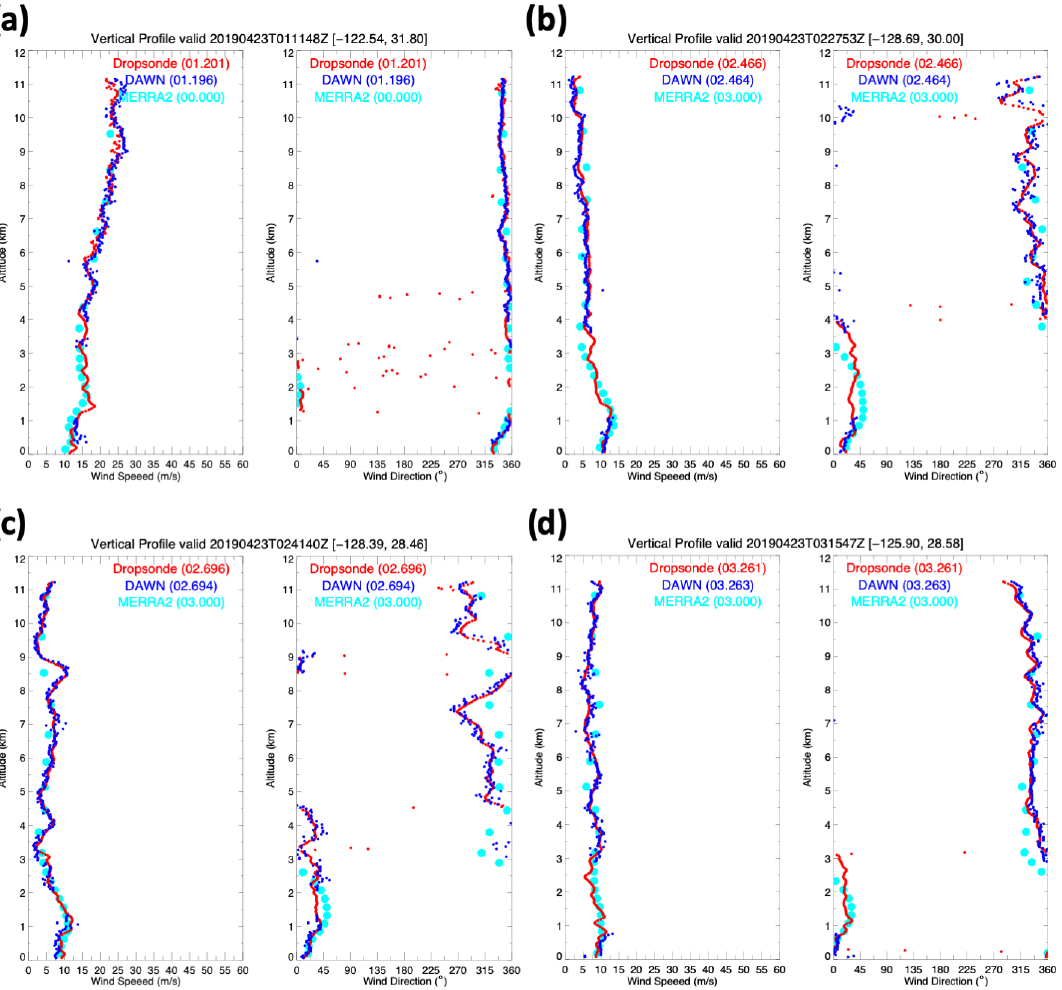
Figure 7. Dropsonde (red), DAWN (blue), and MERRA-2 (cyan) for DAWN profiles at (a) 0111, (b) 0227, (c) 0241, and (d) 0315UTC on 23 April